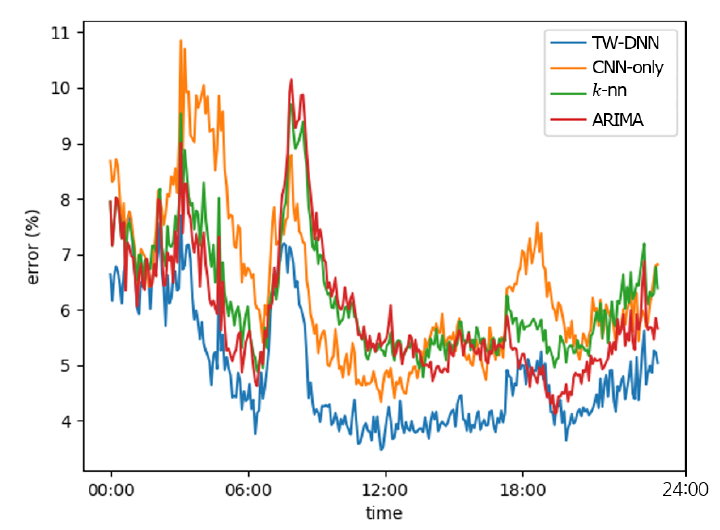
Figure 8. MAPE error of prediction models for Case I.